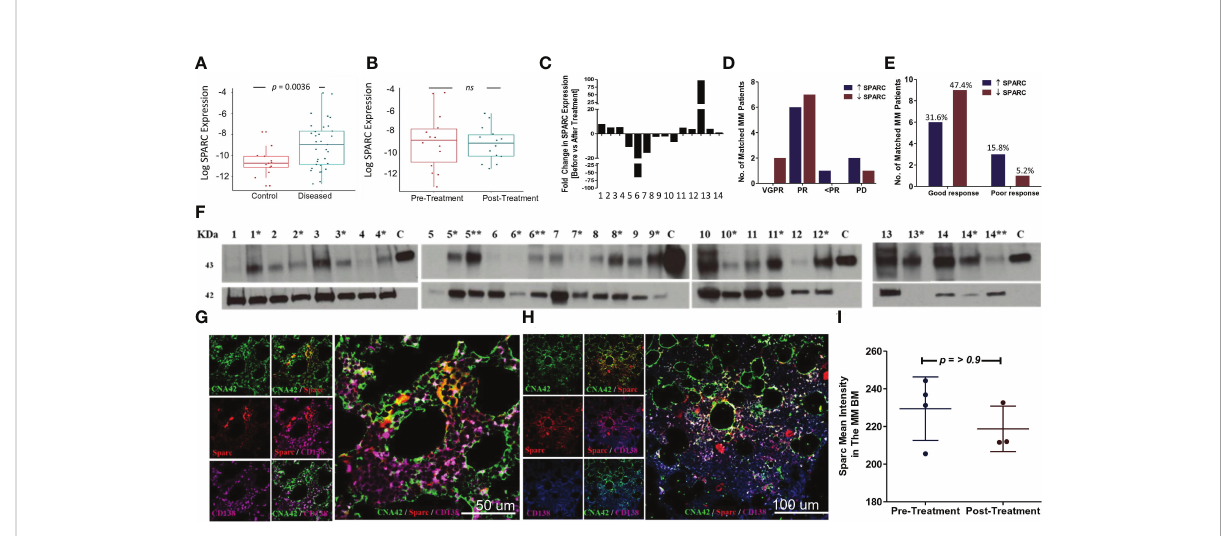
FIGURE 3 SPARC expression in the BM of MM patients and the effect of treatment. Log SPARC expression level in BM of diseased MM patients (before ttt) and normal BM of control patients (A) . The y-axis represents the relative expression of SPARC to 18S after log transformation, whereas the x- axis represents the patients ’ status whether normal control patients or diseased MM patients before treatment. Unpaired T-test with Welch ’ s correction revealed a statistically signi fi cant difference between log SPARC expression (2 - D CT ) in MM diseased patients (n = 33) and the control patients (n = 13), p value = 0.0036. Log SPARC gene expression level (2 - D CT ) in 14 matched MM patients at baseline and post-baseline (B) . The y-axis represents the relative expression of SPARC to 18S after log transformation, whereas the x-axis represents the MM patients ’ status at different time points (baseline and after treatment). Paired T test revealed no statistically signi fi cant difference between log SPARC expression (2 - D CT ) in matched MM patients before treatment (baseline) and after treatment (post baseline), n: number of patients (n = 14), p-value = 0.6364. SPARC gene expression (2 - DD CT ) fold change (FC) after treatment in 14 matched MM patients (C) . SPARC FC (2 - DD CT ) displayed inconsistent patterns, ranging from -64.7 to 96.75 reduced and upregulated folds due to treatment. SPARC gene expression FC strati fi cation in 14 matched MM patients based on their response to therapy outcomes: VGPR/PR (good response) and <PR/PD (poor response) (D, E) . Fisher ’ s exact test did not show any statistically signi fi cant differences between the increased and decreased SPARC FCs as regards their response to therapy outcomes, p-value= 0.3034. Western blotting of BM tissue lysates show the changes in SPARC protein expression levels in 14 MM patients at their initial diagnosis (no asterisk) and following treatment [*, **; fi rst and second follow-up respectively] (F) . b -Actin was used as internal loading control, and human recombinant SPARC protein 5 ng was used as a positive control, lane C. Confocal imaging of SPARC (red), CNA42/FDCs (green), and CD138/PCs (purple) in BM of a MM patient before treatment (BM in fi ltrated with 50% PCs) (G) , and after treatment (BM in fi ltrated with 20% PCs) (H) . Sections are shown in three separate channels. The dual-color overlay of SPARC and FDCs (colocalization giving yellow/ orange color; shows SPARC secretion from FDCs in BM), SPARC and CD138, and FDCs and CD138 (colocalization giving a white color) are shown. The triple-color overlay of SPARC, FDCs, and CD138 is shown. Immuno fl uorescence semiquantitative analysis of SPARC fl uorescence signal intensity in three MM patients before and after treatment using ImageJ (I) . Wilcoxon matched-pair test did not show any